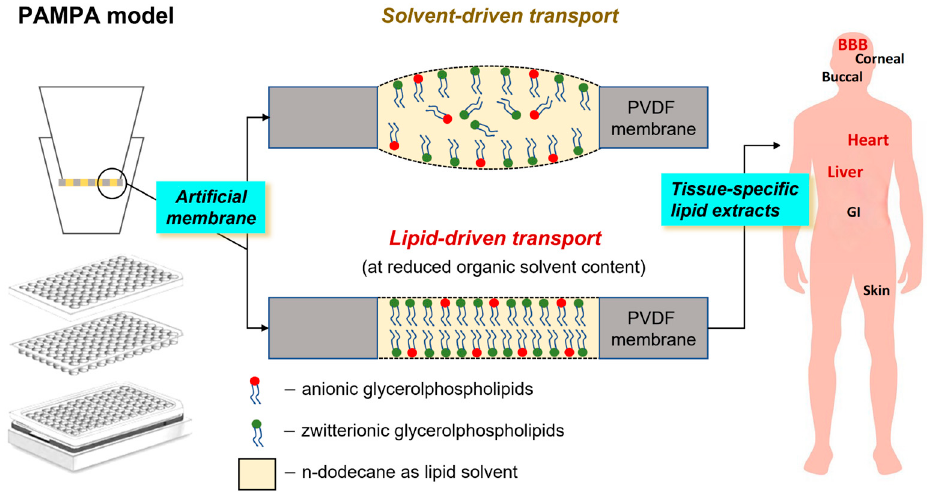
Figure 1. Tissue-specific PAMPA models and lipid-driven hypothesis for the in vitro non-cell perme- ability model (proposed by Thomson et al. [13] and our group [5]). BBB–blood–brain barrier and GI—gastrointestinal tract.